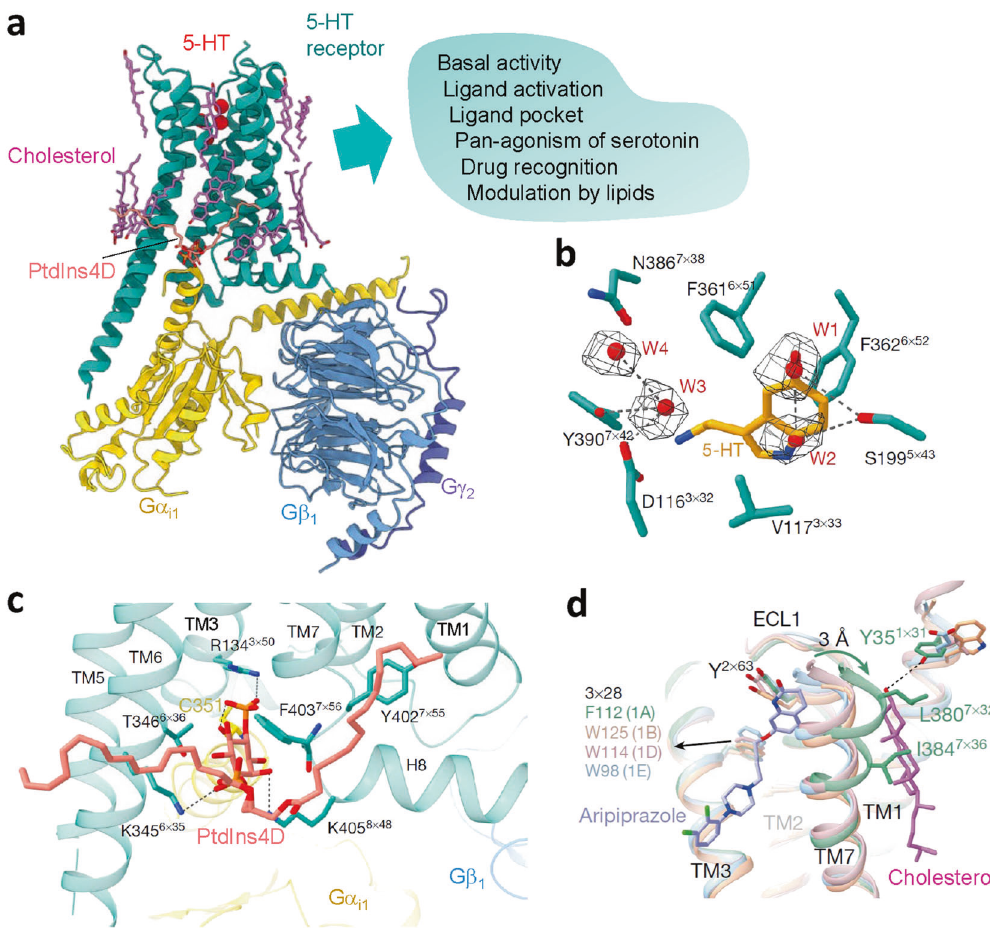
Fig. 1 Structural analysis of 5-HT1 receptor activation and modulation by lipids. a Structural model of 5-HT1A in complex with Gi and 5-HT in the ligand pocket, and with associated lipids (left). The structure – function relationships discovered on the basis of this and four other resolved structures (right). b Water molecules (W1 – W4 shown in mesh) in the apo-5-HT1A ligand-binding pocket. Hydrogen bonds are shown with dashed lines. c Interactions of PtdIns4P at the 5-HT1A – Gi interface, with interacting residues shown in sticks. Hydrogen bonds are shown with dashed lines. d Side view of different TM7 conformations and TM7 interactions with aripiprazole and cholesterol between 5-HT1A, 5-HT1B, 5-HT1D, and 5-HT1E. ECL1, extracellular loop 1. Reprinted by permission from Springer Nature: Nature, Xu et al. © (2021), 1 under exclusive licence to Springer Nature Limited